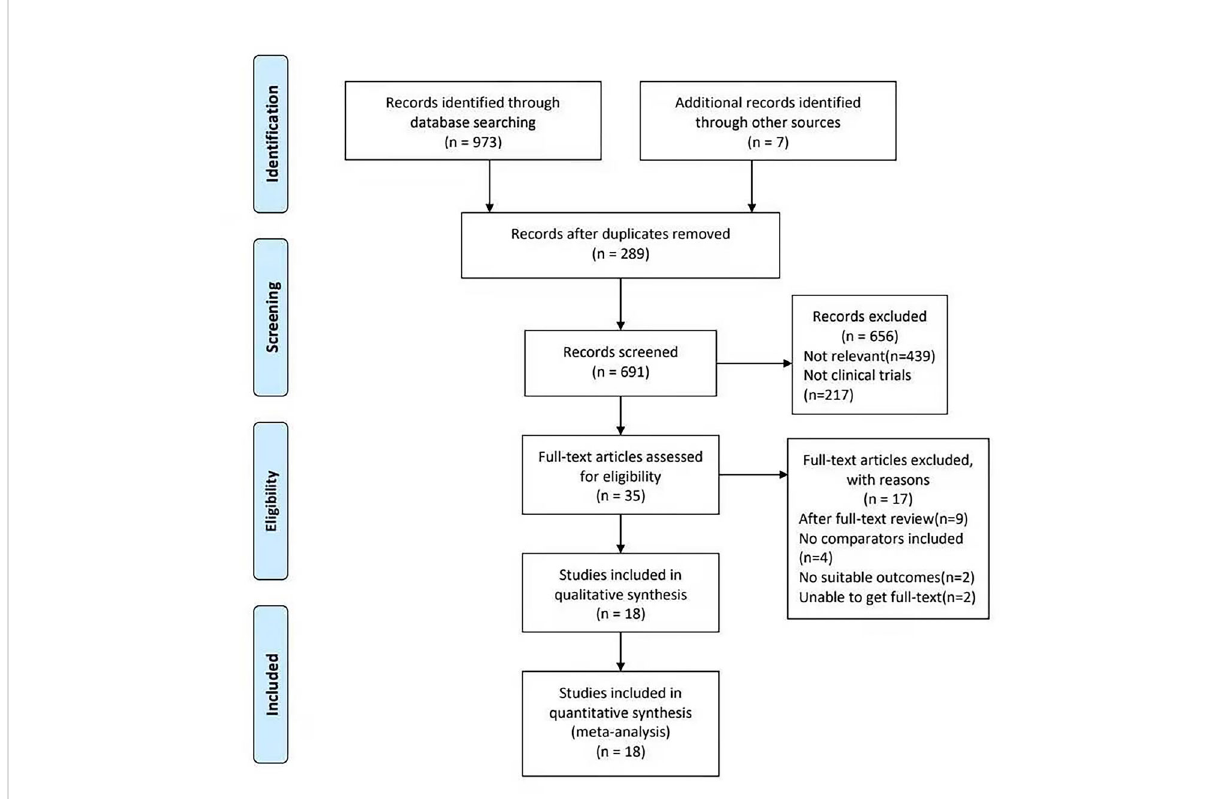
FIGURE 1 PRISMA Flow Diagram on the literature selection process in this meta-analysis. PRISMA Flow Diagram showing how studies were searched and screened. The fl ow diagram template was adapted from the 2009 PRISMA statement